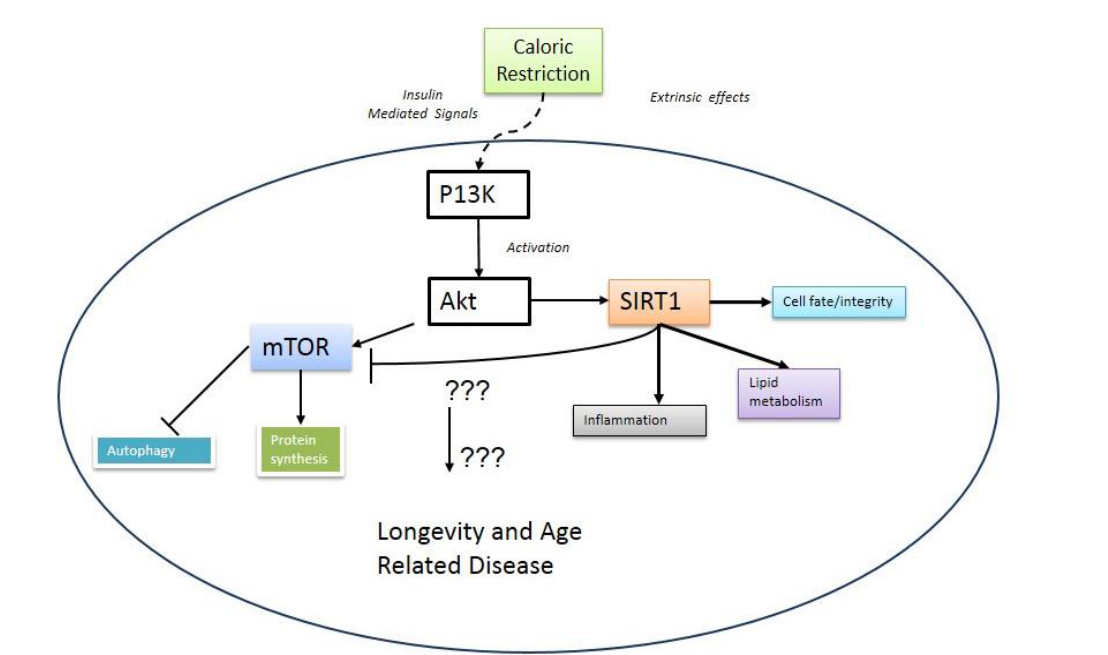
Figure 1. A coarse-grained overview of the metabolic pathways regulated by mTOR and SIRT1. The figure also shows SIRT1 inhibiting mTOR, as suggested by Ghosh et al.